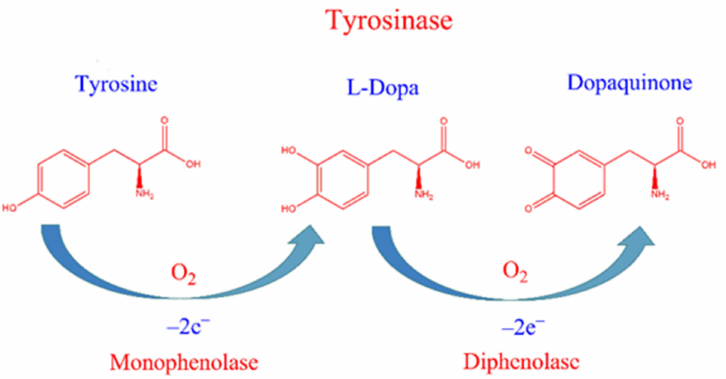
Figure 1. Tyrosinase enzyme reactions.